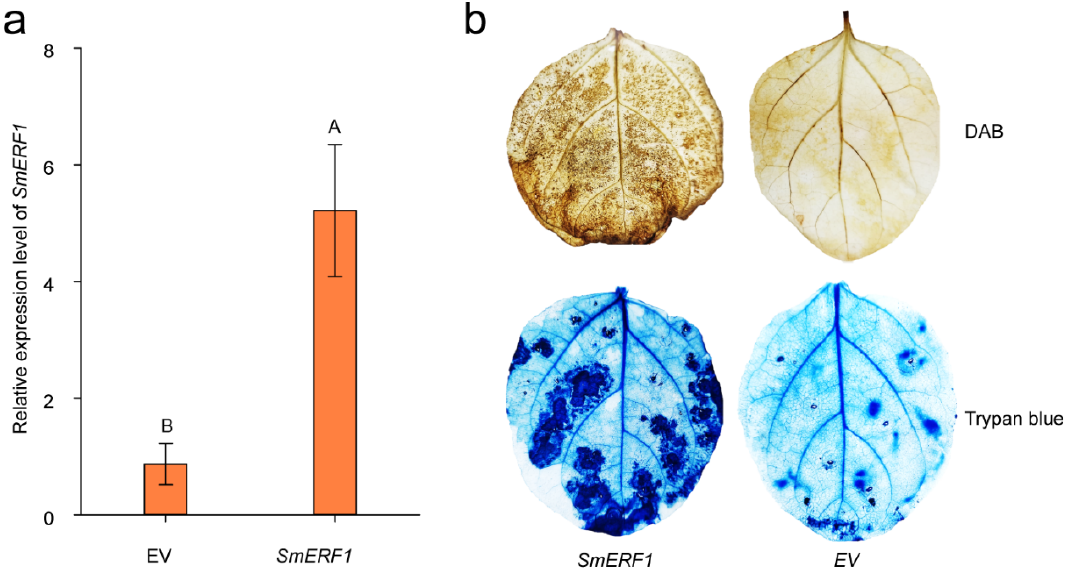
Figure 8. Transient overexpression of SmERF1 in eggplant leaves. ( a ) qPCR-based detection of SmERF1 transcript expression levels in leaves with transiently overexpressed SmERF1 and the empty vector (EV) at 48 h post-infiltration. ( b ) DAB and trypan blue staining of leaves infiltrated with Agrobacterium tumefaciens GV3101 cells transformed with 35S:SmERF1-GFP or 35S:GFP constructs at 3 days post-infiltration. Data are the means ± standard deviation from four biological replicates. Different capital letters between samples denote significant differences according to Student’s test ( p < 0.01).